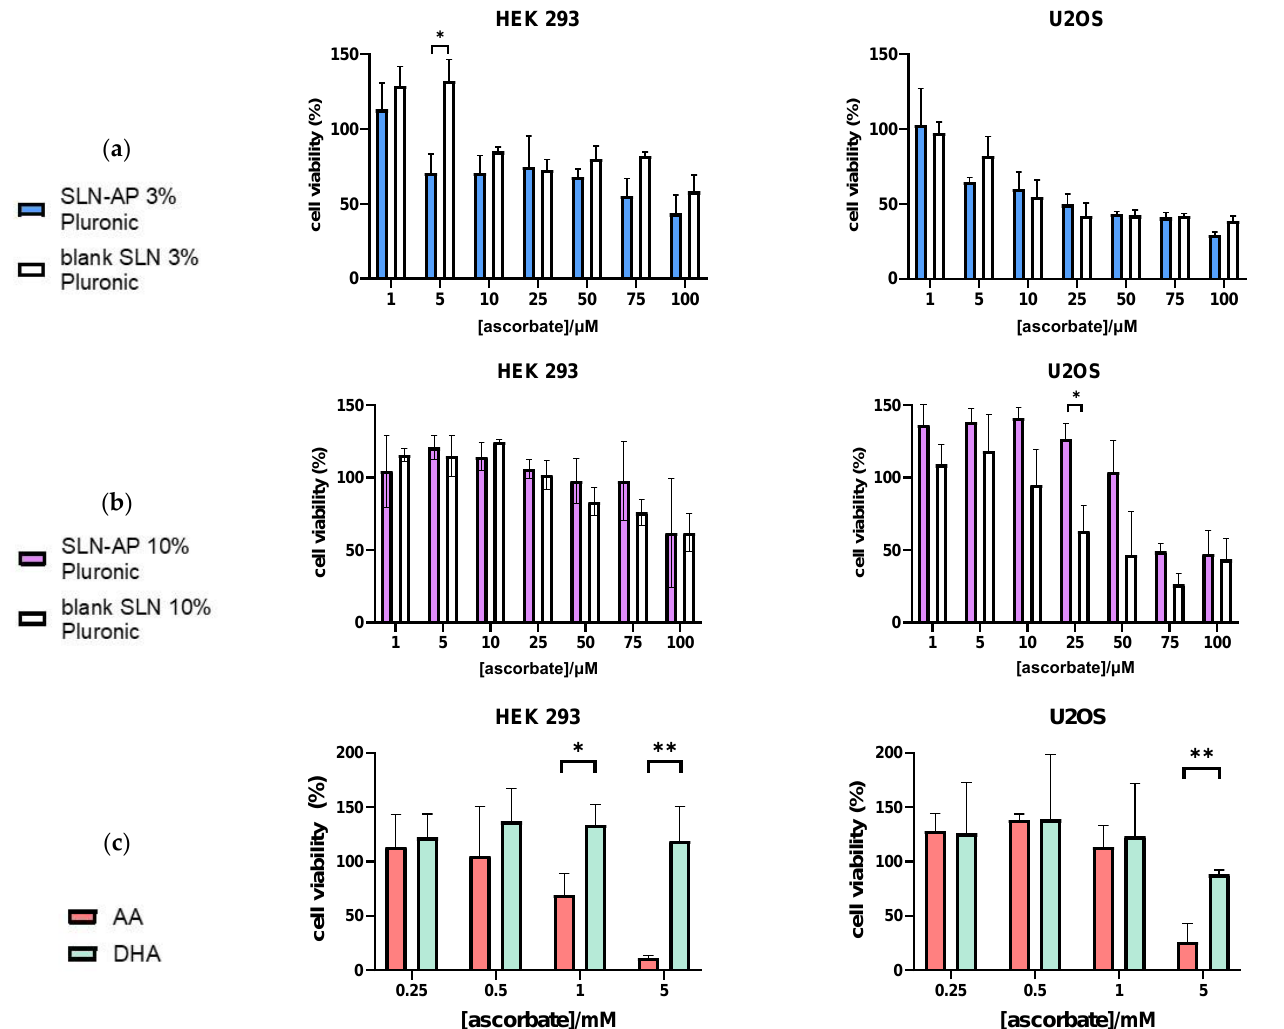
Figure 6. Cytotoxicity of SLN AP and blank SLN synthesized with either 3% ( a ) or 10% ( b ) Pluronic F-68, as well as AA and DHA in free form ( c ), on HEK 293 and U2OS cell lines was tested by MTT test during 24 h. All treatments were normalized to ascorbate composition. Data are expressed as percentage of negative control, mean ± sd, n = 3. Holm –Šídák multiple unpaired t-tests were performed. Statistical significance: * p ≤ 0.05, ** p ≤ 0.01 .